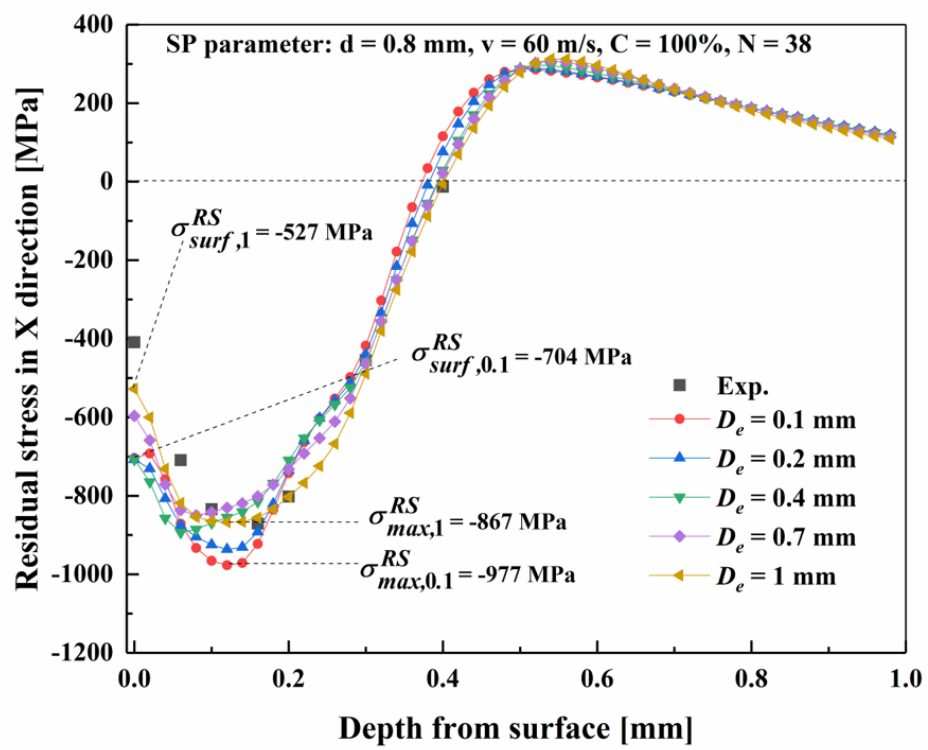
Figure 15. Residual stress depth profile with different evaluation area in stochastic dimple pattern SP model (SP parameter: d = 0.8 mm, V = 60 m/s, C = 100%, N = 38).